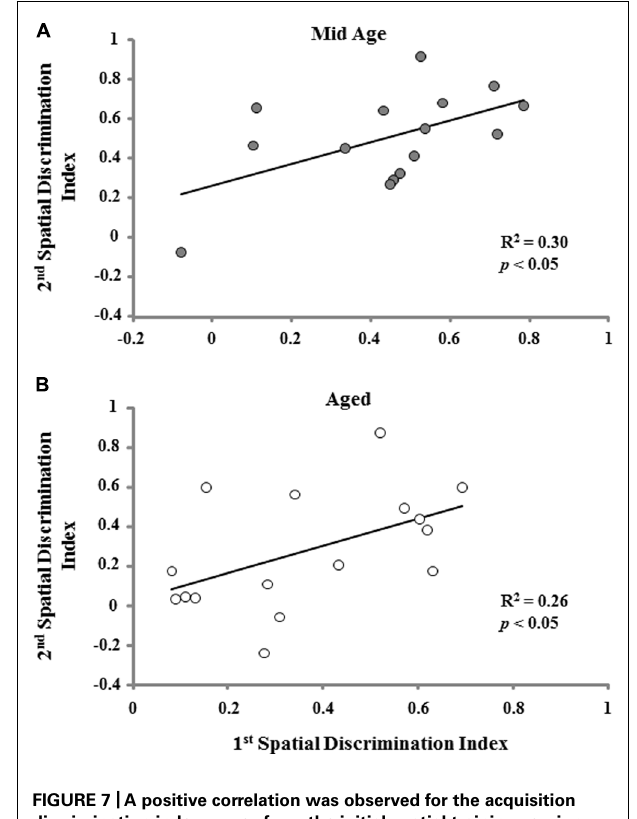
FIGURE 7 |A positive correlation was observed for the acquisition discrimination index scores from the initial spatial training session and episodic memory training to a novel platform position during the second training session for middle-age (MidAge) (A) and aged (B)